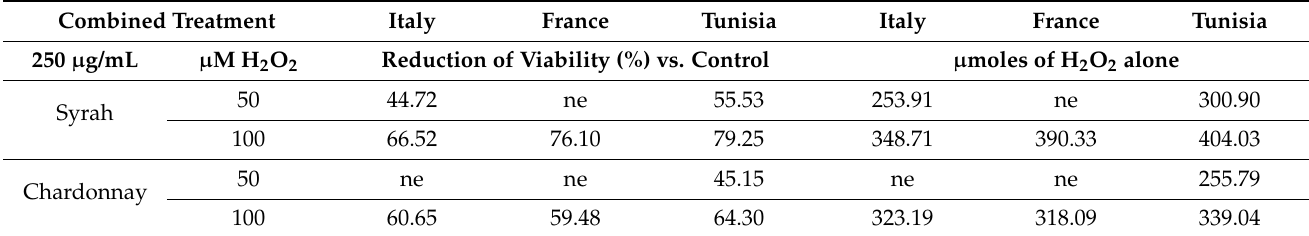
Table 4. Prooxidant activity of combined treatments with 250 µ g/mL of Syrah or Chardonnay extract with 50 and 100 µ M of H 2 O 2